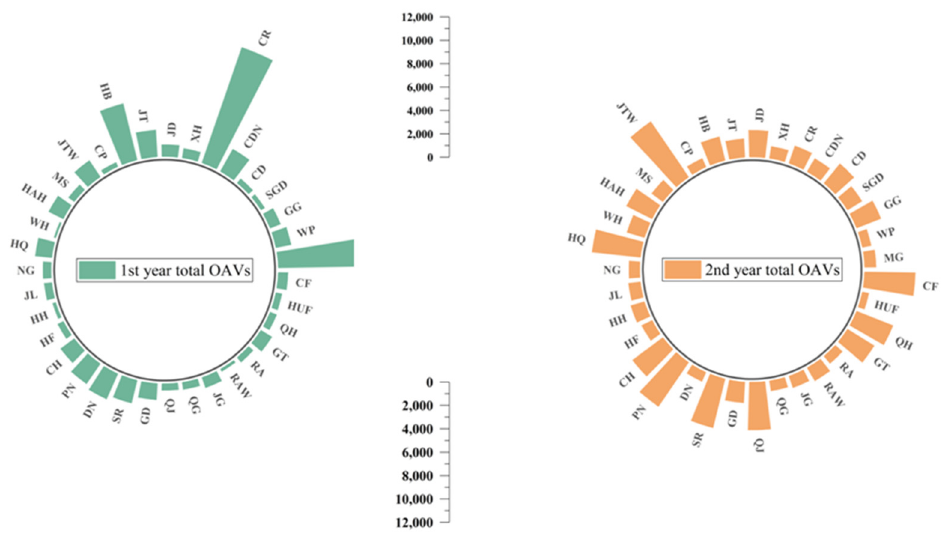
Figure 4. The sum of total OAVs for each apple varieties over two years. The apple cultivar abbreviation codes were described in Table 1.